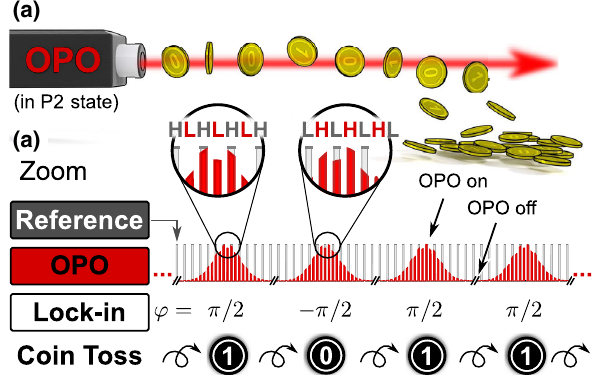
FIG. 1. Operation principle of the all-optical randomness generator. (a) The output of an optical parametric oscillator (OPO) generates two different output states unambiguously. Both outputs are equienergetic and equiprobable, and are based on the transient oscillation of the OPO. We associate the outcomes to an output bit, comparable to a coin toss. (b) The detection is performed by a phase measurement ( φ ) against an external reference clock, supplied by the pump laser. H and L denote the different pulse energy outputs of the OPO, which operates in the period-2 state, named